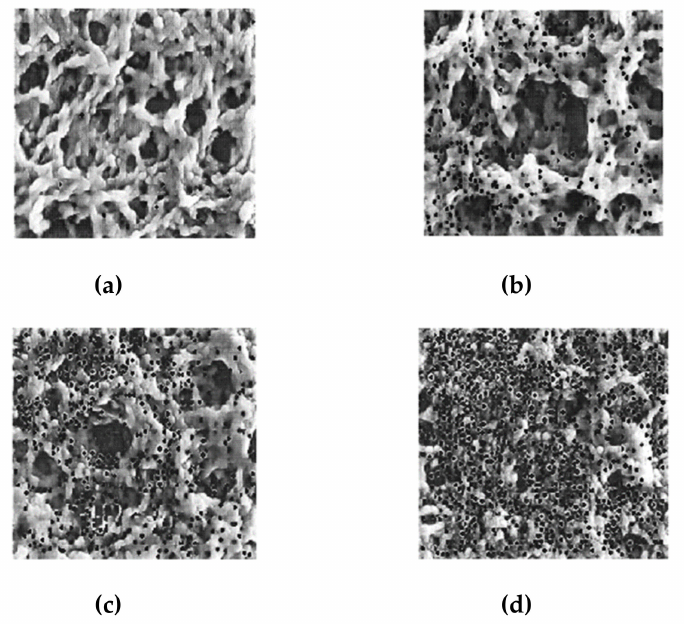
Figure 4. ACGAN generated images of the PVDF membrane structure and particles for four di ff erent particle concentrations in feed water ( a ) 0, ( b ) 2, ( c ) 5, and ( d ) 8 mg / L (200 × 200